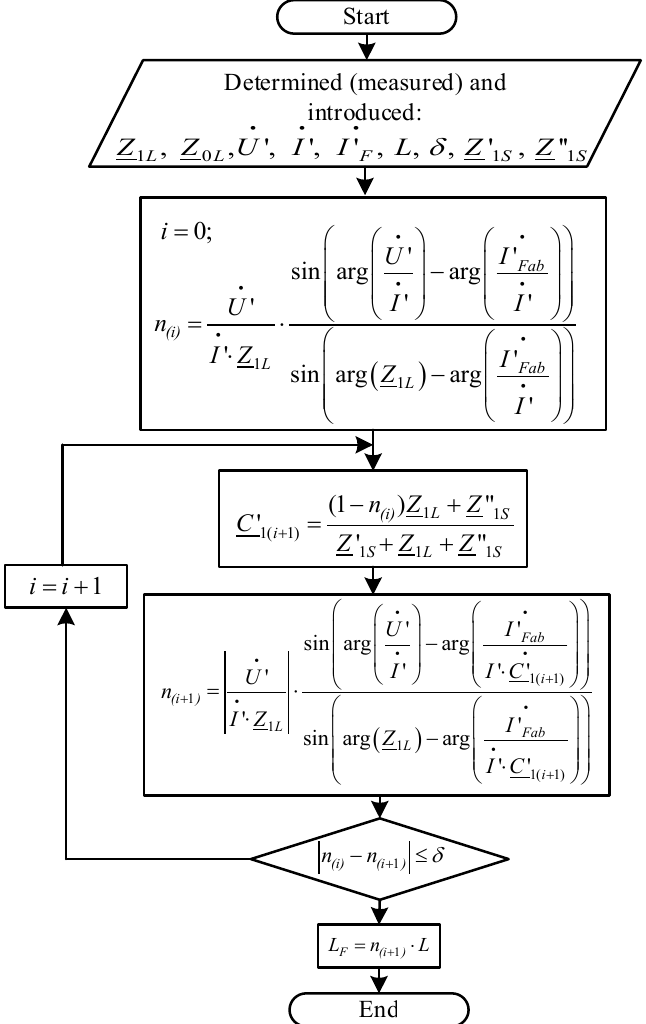
Figure 6. Block diagram of the FL algorithm based on the impedance method for a single-circuit OHPL with two-way power supply.